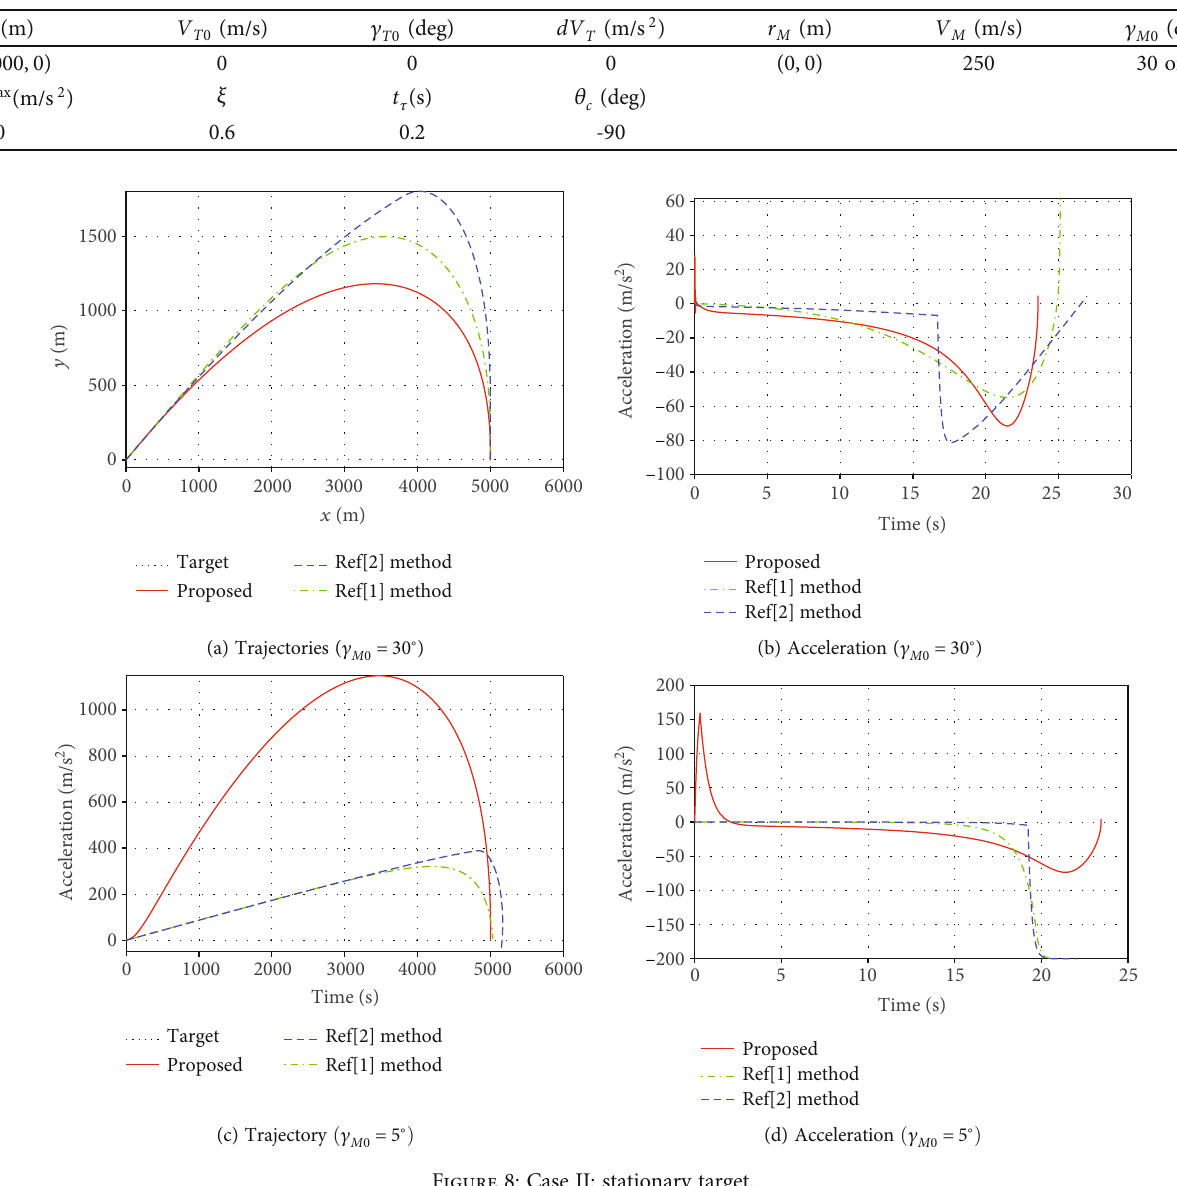
Table 4: Simulation conditions for Case II.